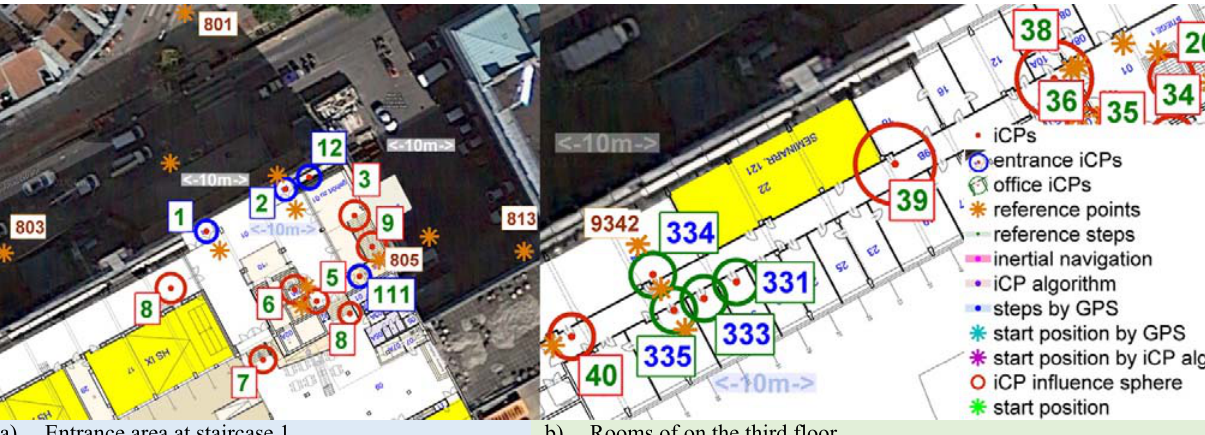
Figure 3. Field test site in a multi-storey office building